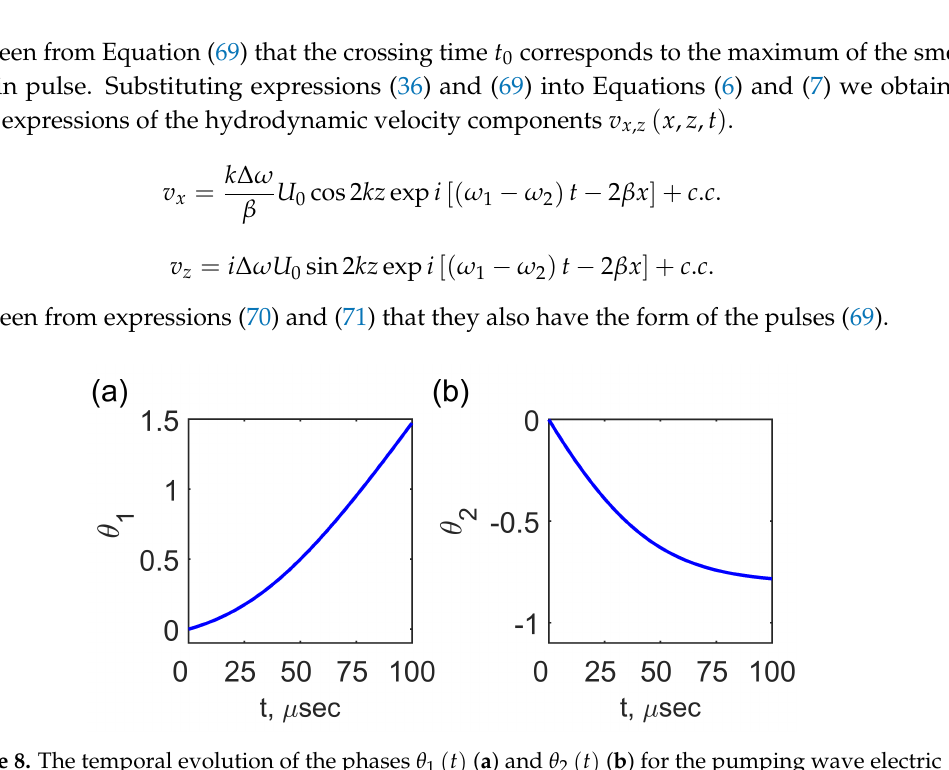
Figure 8. The temporal evolution of the phases θ 1 ( t ) ( a ) and θ 2 ( t ) ( b ) for the pumping wave